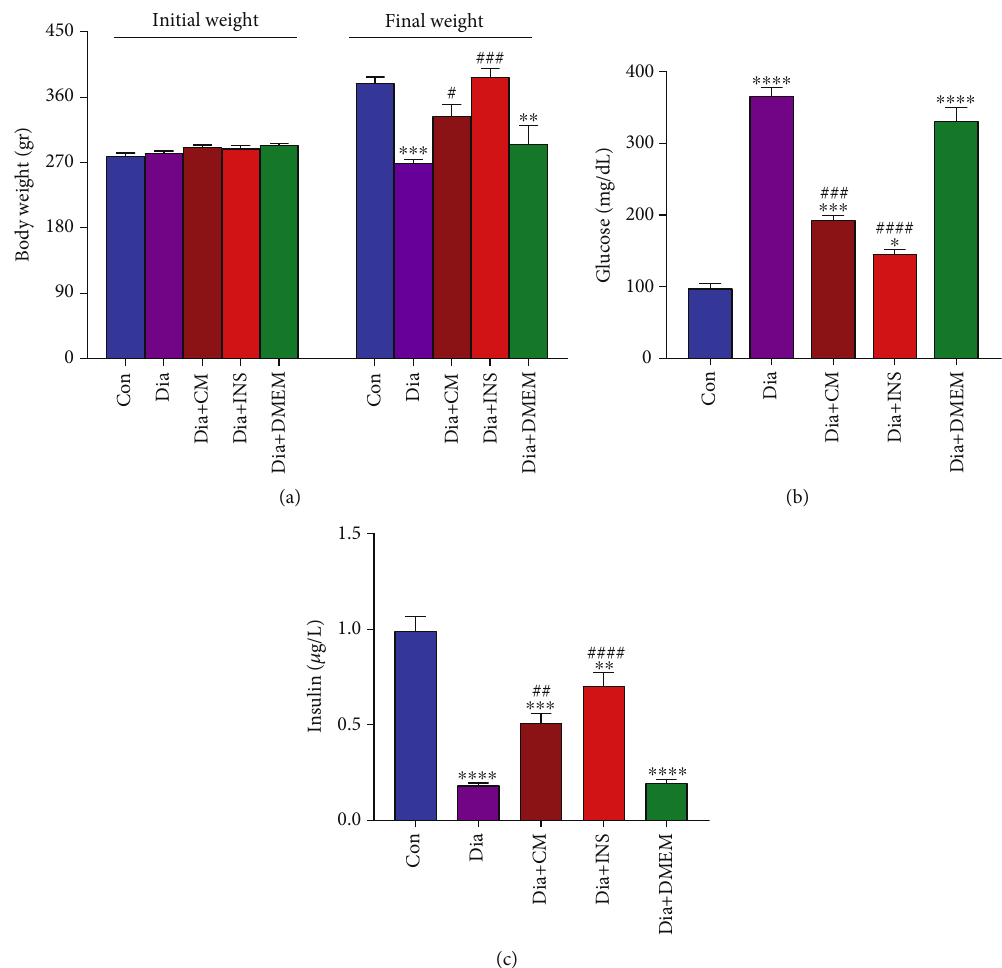
(Figure 5(b), P < 0 : 0001 ), the number of grooming (Figure 5(c), P < 0 : 05 ), and total distance traveled (Figure 5(d), P < 0 : 0001 ) were signi fi cantly reduced in the diabetes group. Compared to the untreated diabetic group, however, WJMSC-CM partially recovered, and insulin sig- treated diabetic groups (Figure 5(a)). In addition, the time spent in the center (Figure 5(b)) and the number of